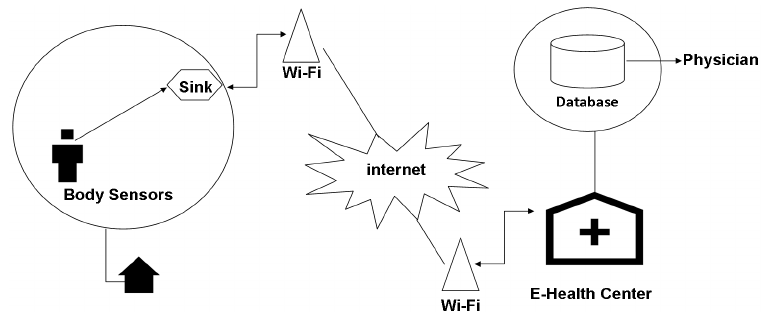
Figure 7. Wireless Body Area Network (WBAN) Architecture.